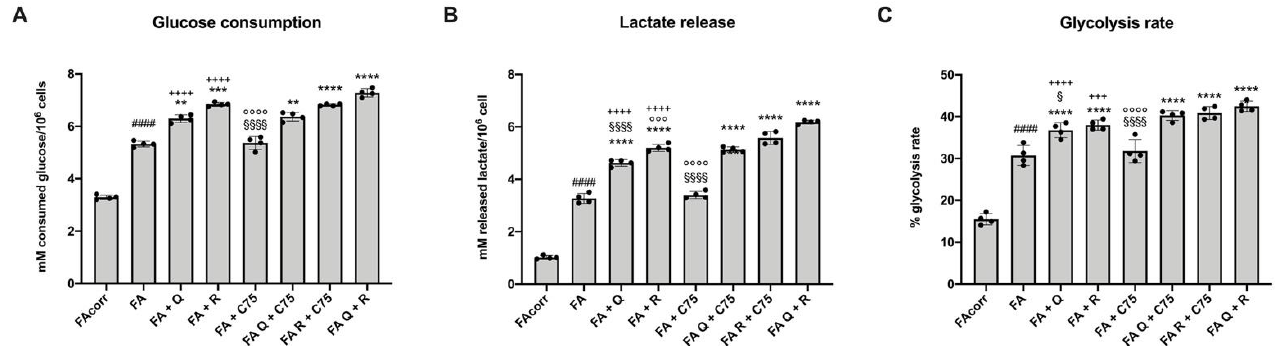
Figure 3. Changes in anaerobic glycolysis flux in FA cells treated with quercetin, rapamycin, and C75, alone or in combination. All data represent experiments conducted after 48 h of drug treatments. ( A ) Glucose consumption. ( B ) Lac- tate release in growth medium. ( C ) Glycolysis rate, evaluated as ratio between real lactate release and theoretical lactate release, which corresponds to twice concentration of glucose consumed. (Q = quercetin alone; R = rapamycin alone; C75 = C75 alone; Q + C75 = quercetin/C75 combination; R + C75 = rapamycin/C75 combination; Q + R = quercetin/rapamycin combination). Each graph represents four independent experiments and data are expressed as mean ± S.D. For FA and FA-corr cells, data are representative of four different Fanc-A lymphoblast cell lines. Statistical analysis was performed via one-way ANOVA followed by Tukey multiple comparison test. #### indicates a p < 0.0001 between FA cells and FA- corr cell lines; **, ***, or **** indicate a p < 0.01, 0.001, or 0.0001, respectively, between untreated and treated FA cells. +++, or ++++ indicate a p < 0.001, or 0.0001, respectively, between treatment with quercetin or rapamycin alone and quercetin/ra- pamycin combination; §, or §§§§ indicate p < 0.05, or 0.0001 between treatment with quercetin or C75 alone and querce- tin/C75 combination; °°°, or °°°° indicate a p < 0.001, or 0.0001, respectively, between treatment with rapamycin or C75 alone and rapamycin/C75 combination.